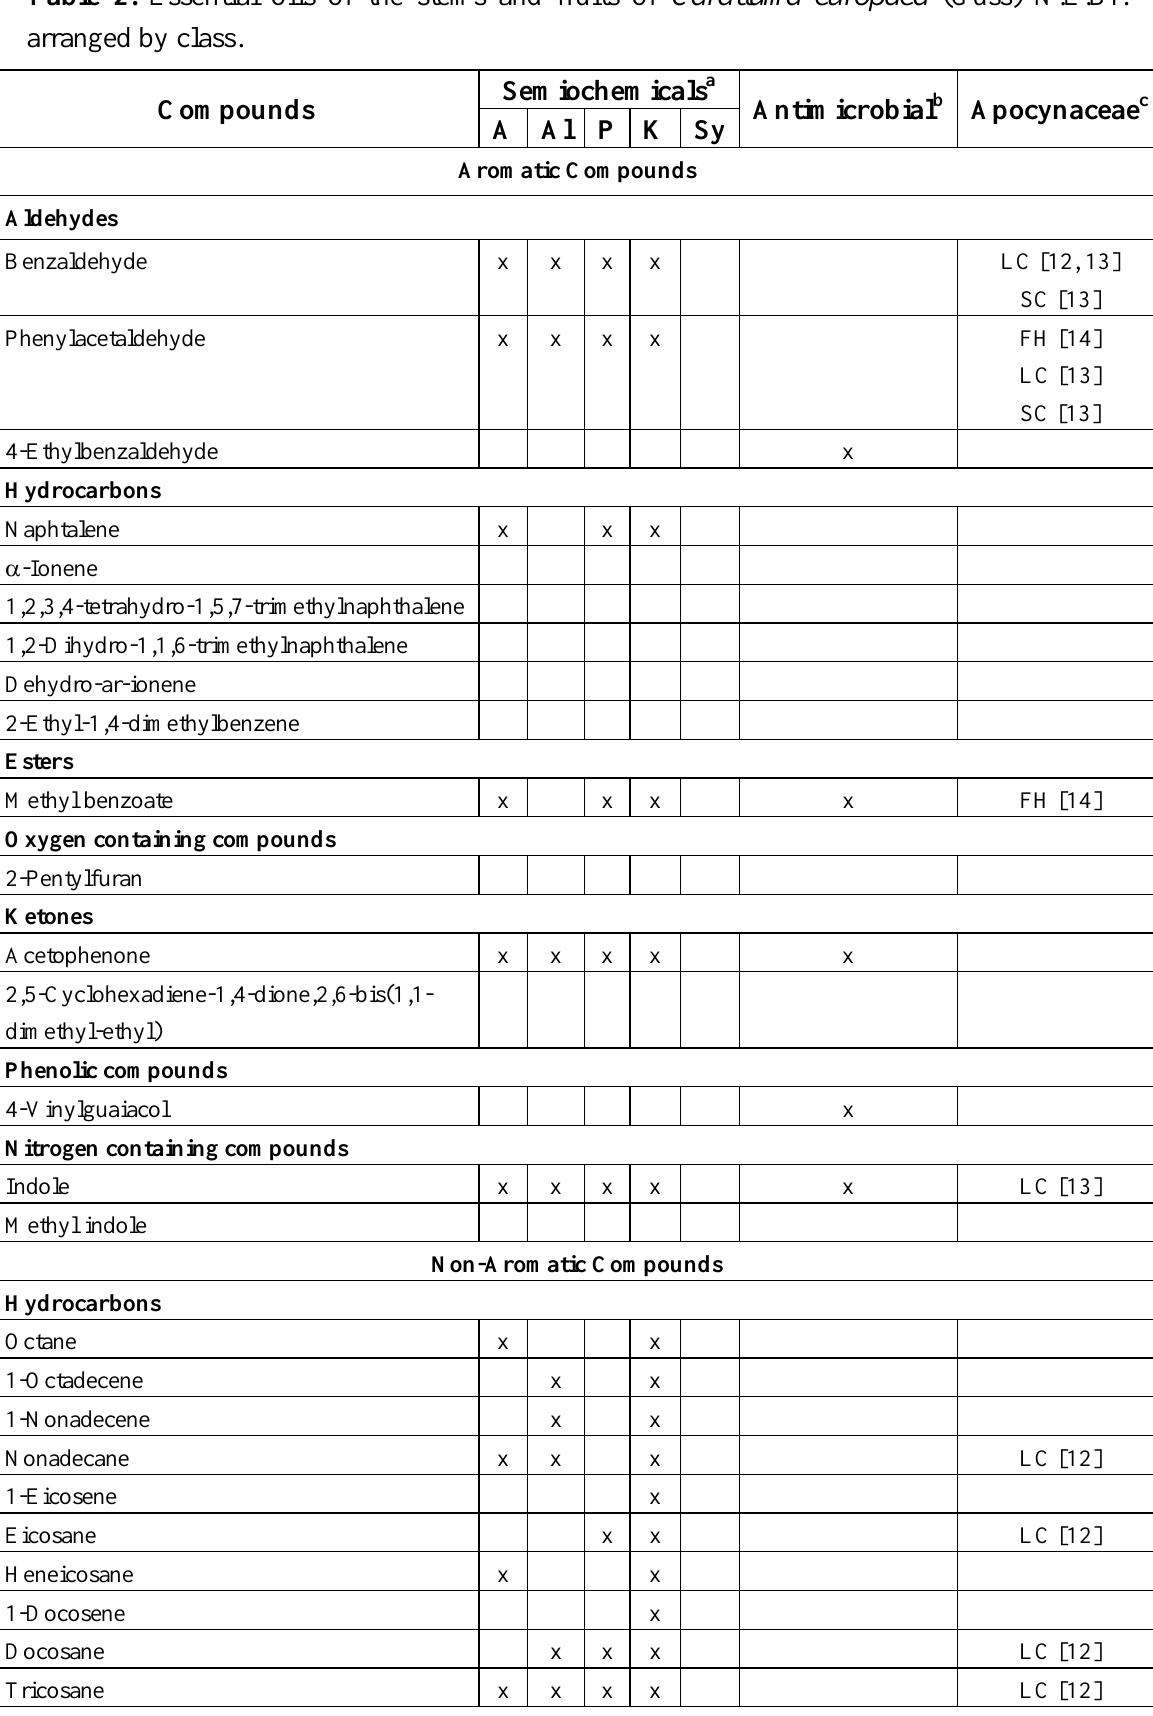
Table 2. Essential oils of the stems and fruits of Caralluma europaea (Guss) N.E.Br. arranged by